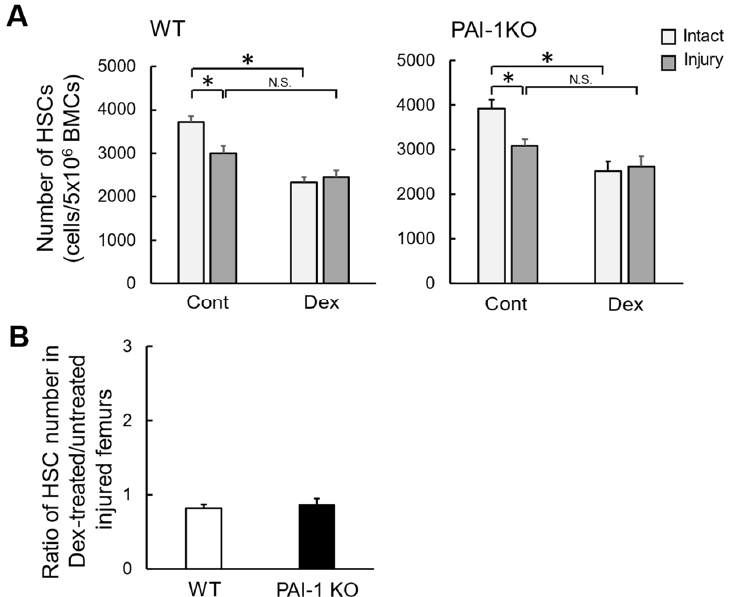
Figure 2. HSCs in bone marrow from damaged femurs after femoral bone injury. ( A ) The numbers of CD34 − , c-Kit + , Sca-1 + , and Lin − cells (HSCs) harvested from the bone marrow of the contralateral intact (intact) and damaged (injury) femurs 2 days after femoral bone injury in WT (left panel) and PAI-1 KO (right panel) mice, as assessed by flow cytometry. Data represent the means ± SEM of 5 experiments (10 mice) in each group. * p < 0.05. BMC, bone marrow cell; Cont, control. N.S., not significant ( B ) Ratio of the bone marrow HSC number in Dex-treated/untreated WT and PAI-1 KO mice 2 days after femoral bone injury assessed by flow cytometry. Data represent the mean ± SEM of 5 mice.